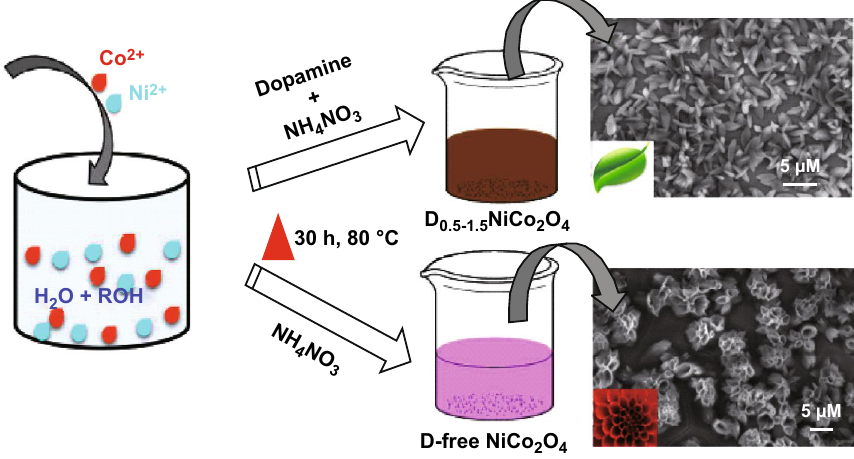
Fig. 10 Schematic illustration of the synthesis of dopamine-free and dopamine-NiCo 2 O 4 nanostructures. Reproduced with permission from Ref. [128], Copyright © 2016 American Chemical